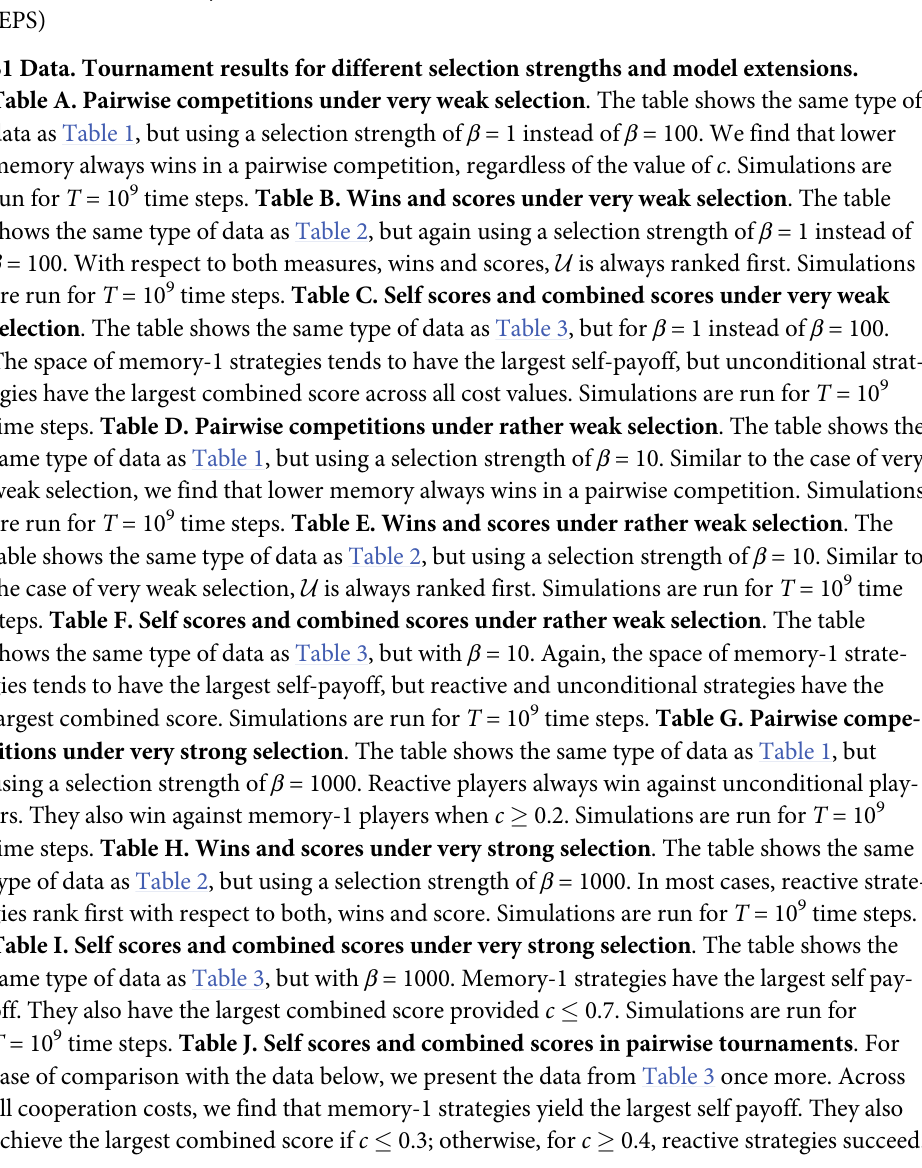
S10 Fig. Evolutionary dynamics of memory spaces for different game structures: Weak